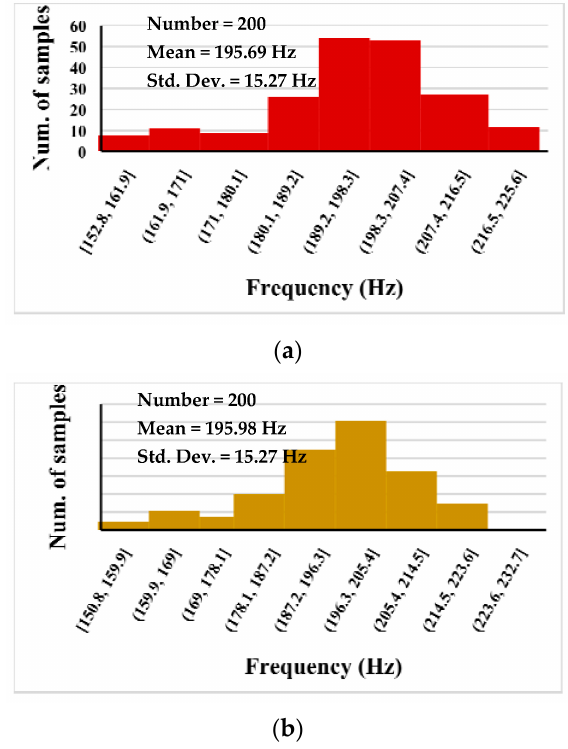
Figure 12. 200-run MC analysis for V o1 ( a ) and V o2 ( b ).